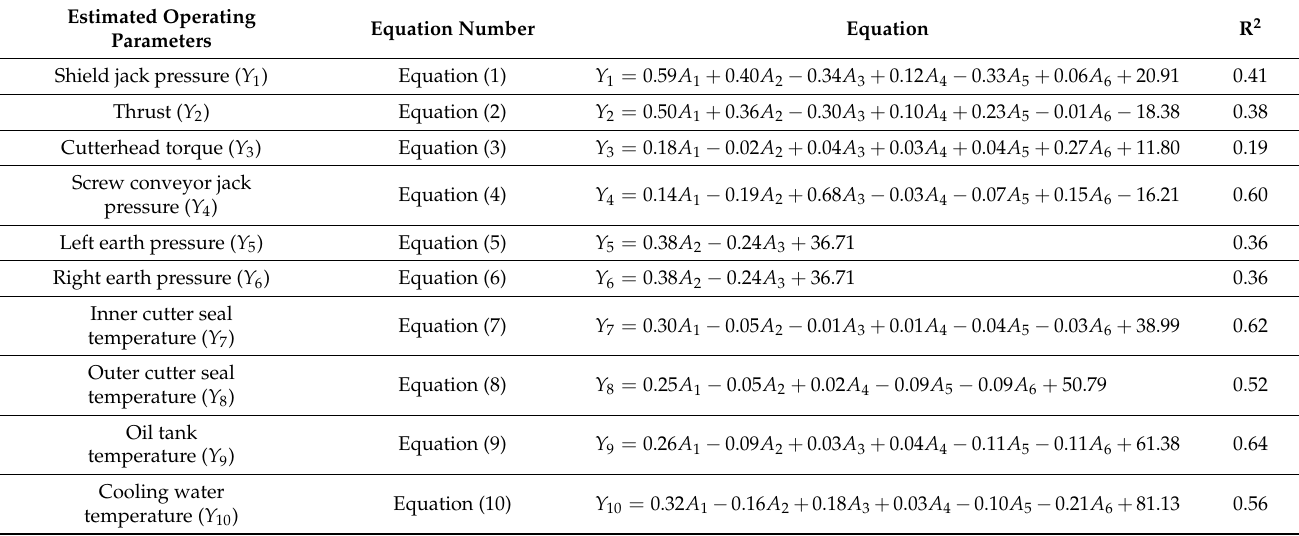
Table 4. Summary of regression equations estimating mechanical responses to operational